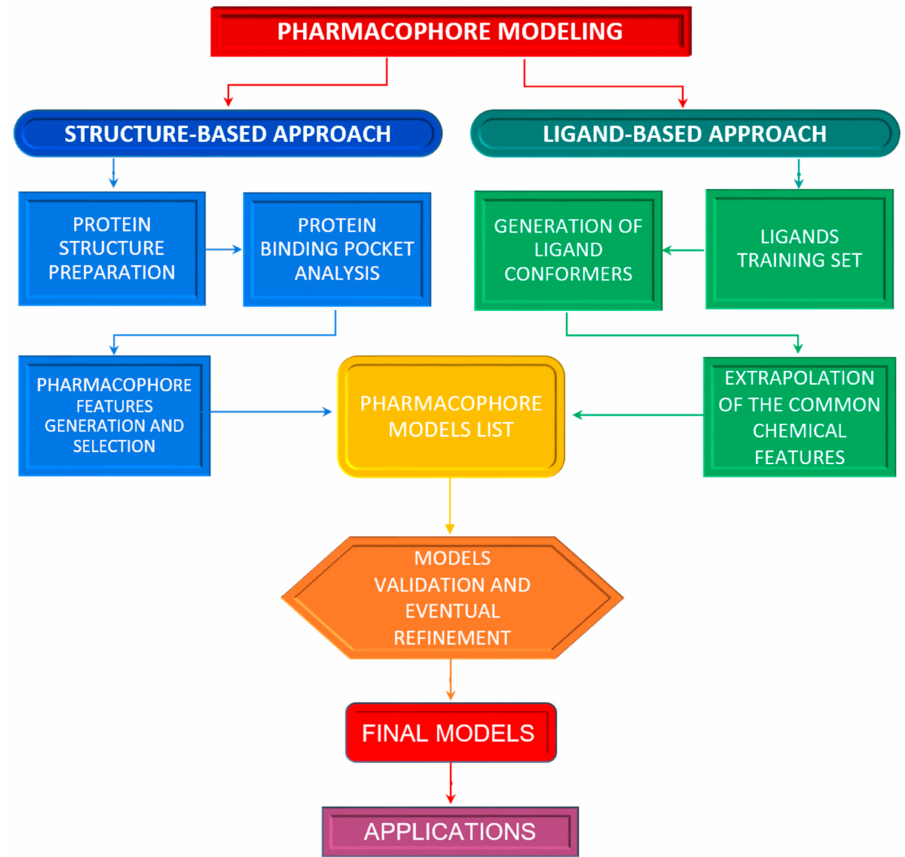
Figure 2. Pharmacophore modeling workflow. A pharmacophore model can be generated using two approaches. In the structure-based approach (on the left side), the structural information of the macromolecular target, alone or bounded to a ligand, is evaluated for its correctness and used to analyze the ligand binding sites in order to derive and select ligand complementary characteristics composing the pharmacophore models. In the ligand-based approach (on the right side), the first step is the construction of a training set made up of known active ligands structures. From each of them, conformers are generated and then used to extrapolate common features that are combined in different pharmacophore models. The resultant models undergo a validation and refinement procedure to obtain the final models exploitable for practical